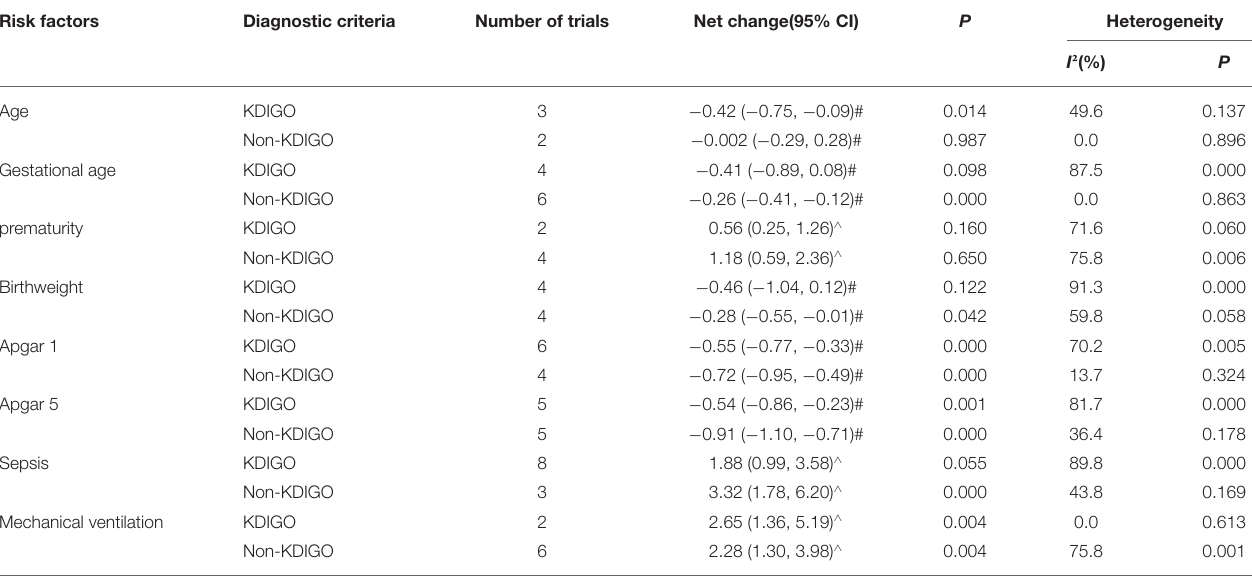
TABLE 7 | Subgroup analyses based on the definition of